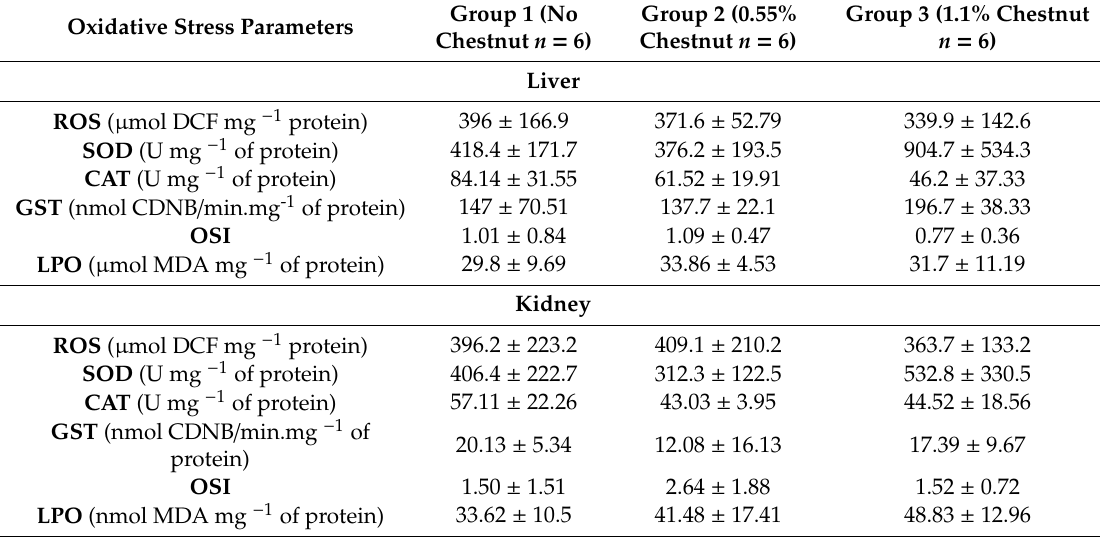
Table 7. Oxidative stress parameters evaluated in the liver and kidney of mice (mean ± standard